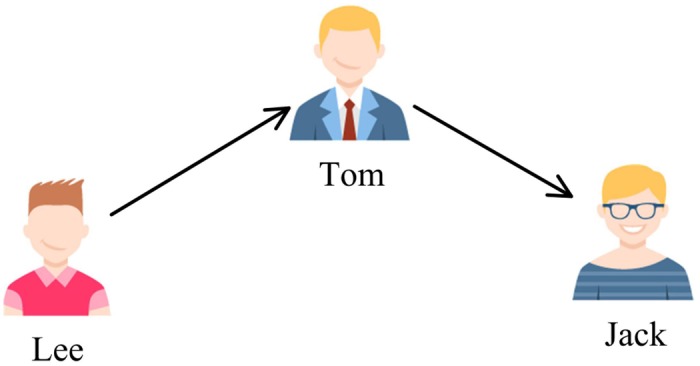
Different relation types in Twitter: The first case.